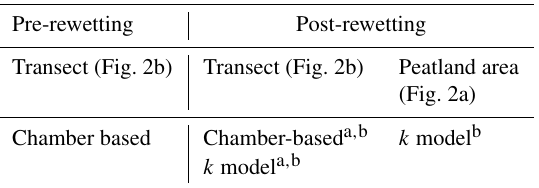
Table C1. Overview of the methods used to determine the atmo- spheric GHG fluxes.